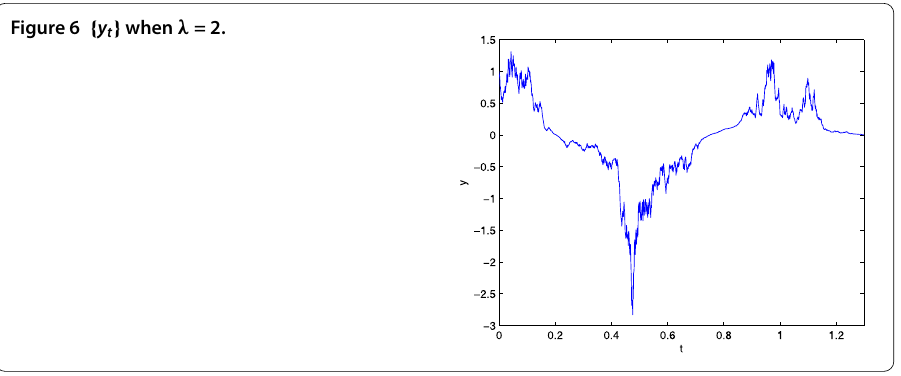
Figure 6 { y t } when λ =